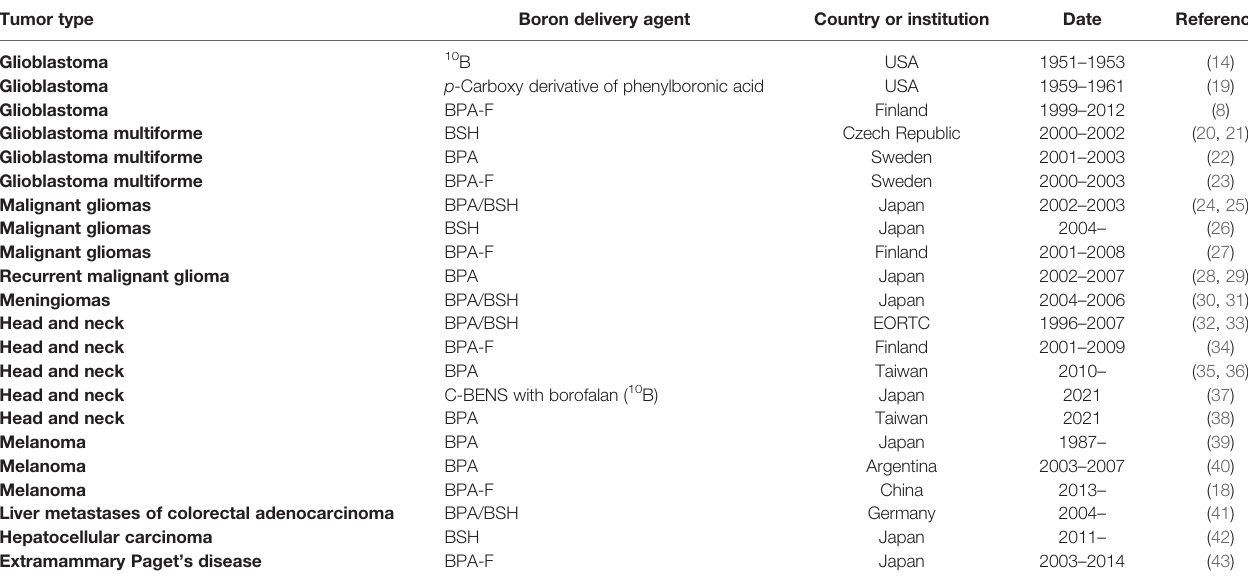
TABLE 2 | Clinical trials of different boron